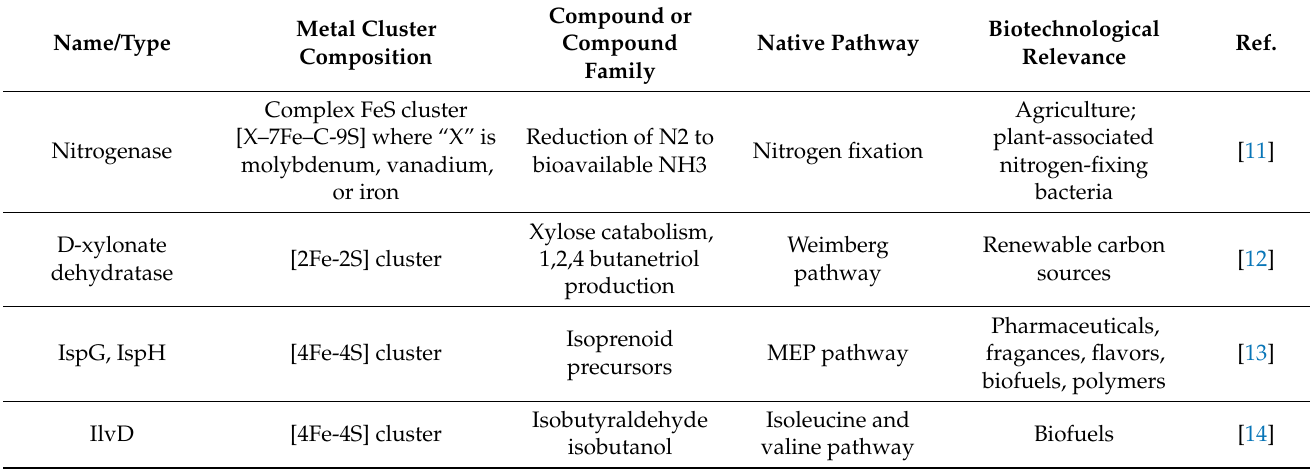
Table 1. Biotechnological relevance of